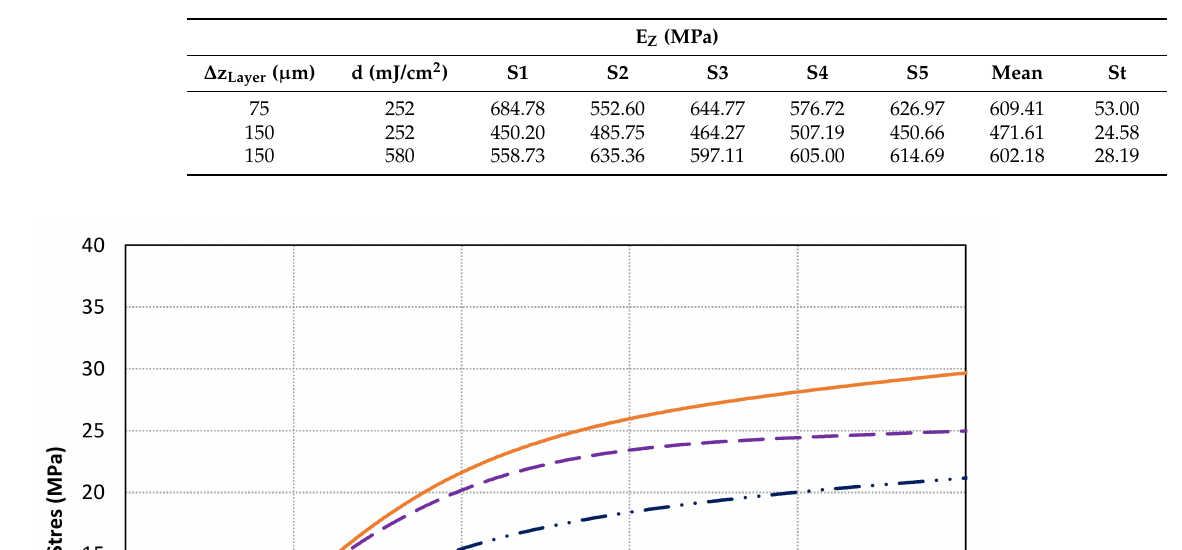
Table 6. Comparison between Secant modulus (MPa) of SL10% Y samples.